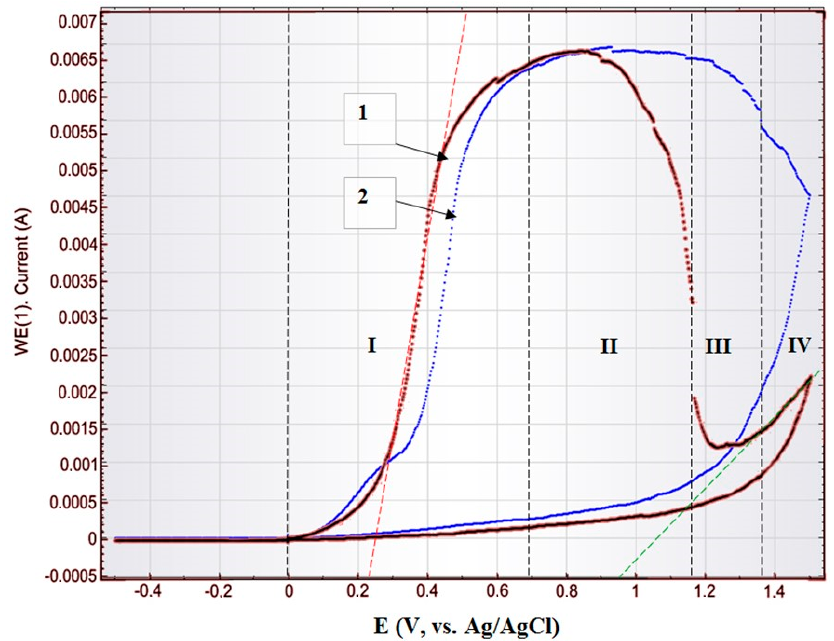
Figure 9. Cyclic voltammograms of the Ti/PAAT/Ni electrode in the 0.9% aqueous solution of NaCl at a potential scanning rate of 0.1 V/s: 1—the first cycle, 2—the fourth cycle. On the anode branch at low potentials (Figure 8 and area I, red line on Figure 9) the Ni oxidation results in the formation of an oxy-hydroxide film, is recorded. Oxidation of Ni in the presence of Cl ions occurs according to the following reactions proposed in [67,68]: